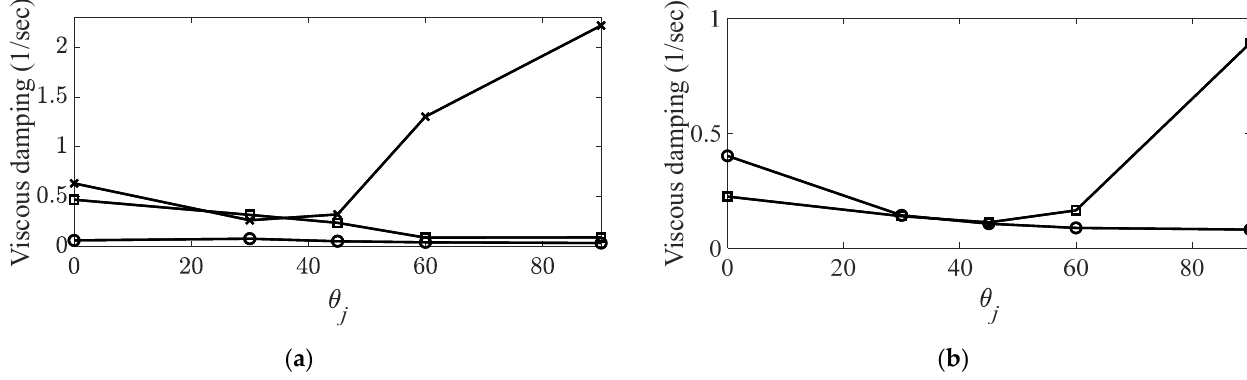
Figure 5. Variations in viscous damping coefficient according to carbon fiber angle: ( a ) : first bending mode, : second bending mode, : third mode; ( b ) : first twisting mode, : second twisting mode.